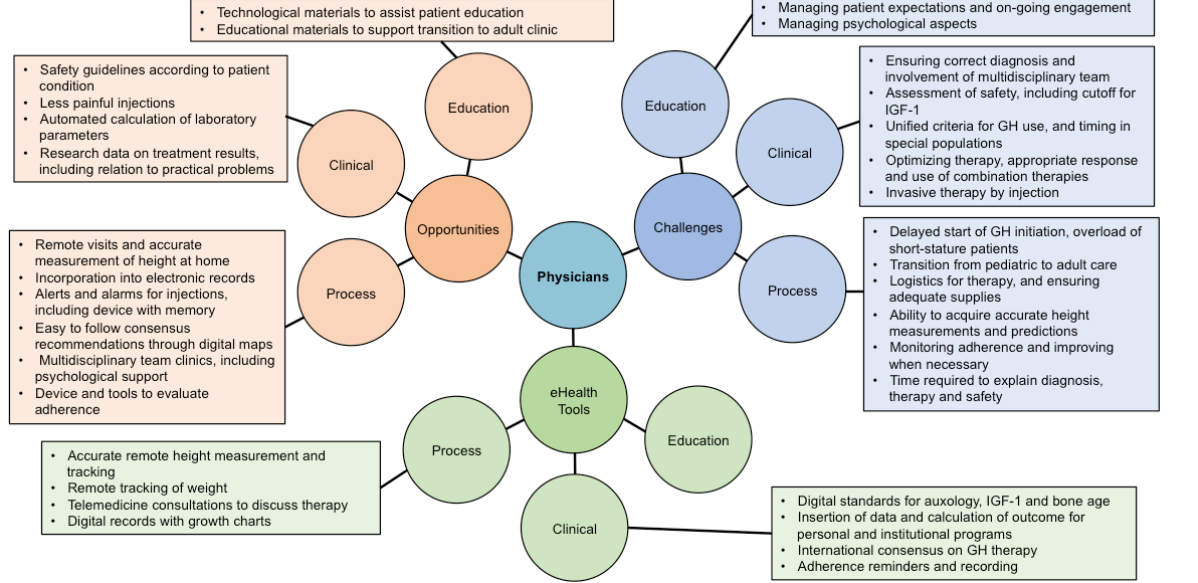
Figure 4. Physician viewpoints regarding growth hormone therapy initiation, monitoring, and transition. Where no comments box is shown, clinicians did not provide any opinions relating to that category. GH: growth hormone; IGF-1: insulin-like growth